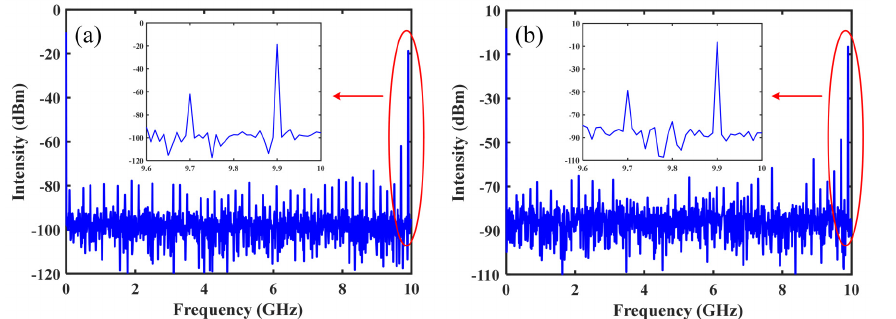
Figure 8. Simulation results for the photonic ADC to digitize a single-tone microwave signal at 9.9 GHz. ( a ) Reconstructed spectrum by using the low-speed NPS-based ADC. ( b ) FFT spectrum by using the equivalent high-speed uniform photonic sampling-based ADC.